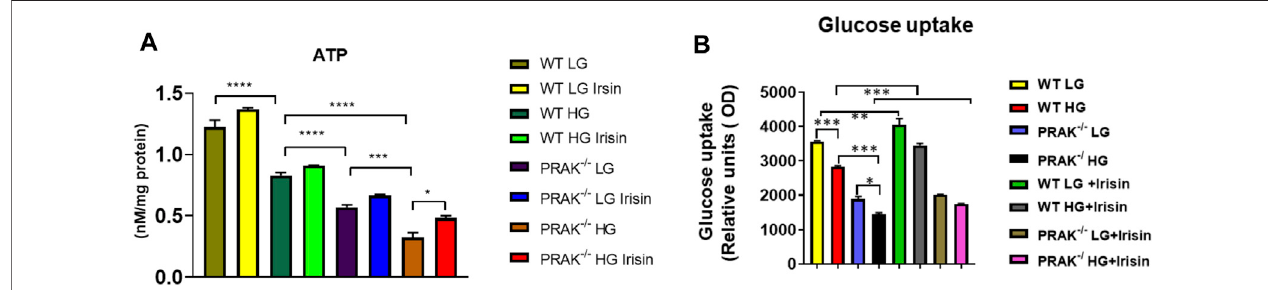
FIGURE 3 | Deletion of PRAK reduced the ATP production and glucose uptakes of cells exposed to high glucose stimulus. (A) PRAK knockdown attenuated ATP content in cells exposed to high glucose. Mitochondria was isolated from C2C12 myoblasts, and the mitochondrial contents of ATP were measured ( n (cid:2) 3/each